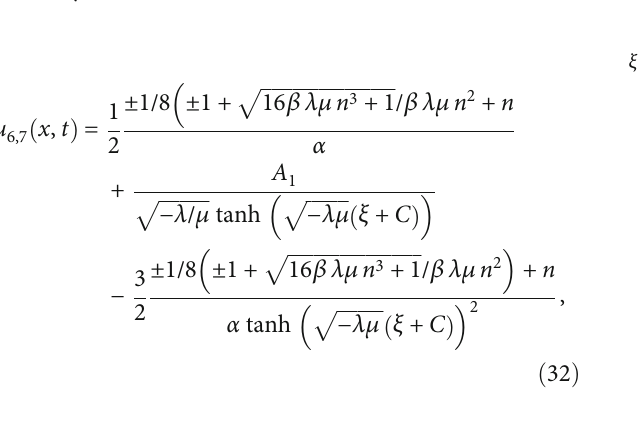
ffiffiffiffiffiffiffiffiffiffiffiffiffiffiffiffiffiffiffiffiffiffiffiffiffiffi p 16 β λμ n 3 + 1